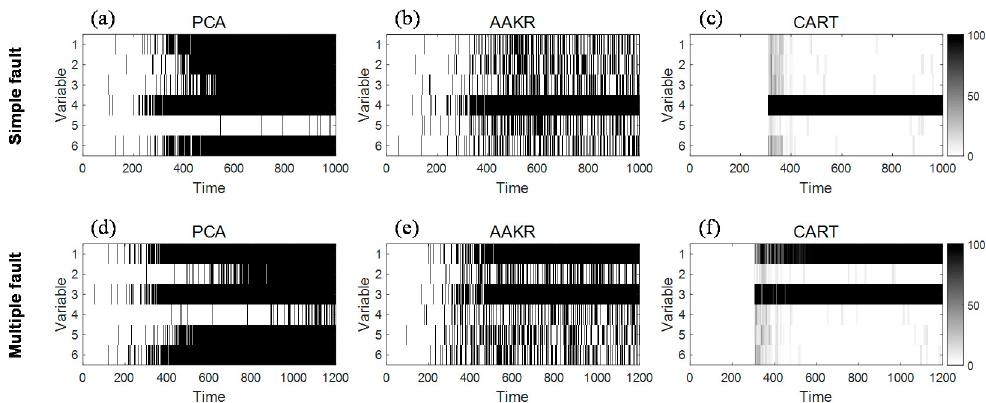
Figure 2. (Simple linear process) Fault isolation results of comparison methods (PCA- and AAKR-based contribution plots) and Method 2: ( a ) (simple fault) PCA-based contribution plot; ( b ) (simple fault) AAKR-based contribution plot; ( c ) (simple fault) variable importance values with Method 2; ( d ) (multiple fault) PCA-based contribution plot; ( e ) (multiple fault) AAKR-based contribution plot; ( f ) (multiple fault) variable importance values with Method 2.